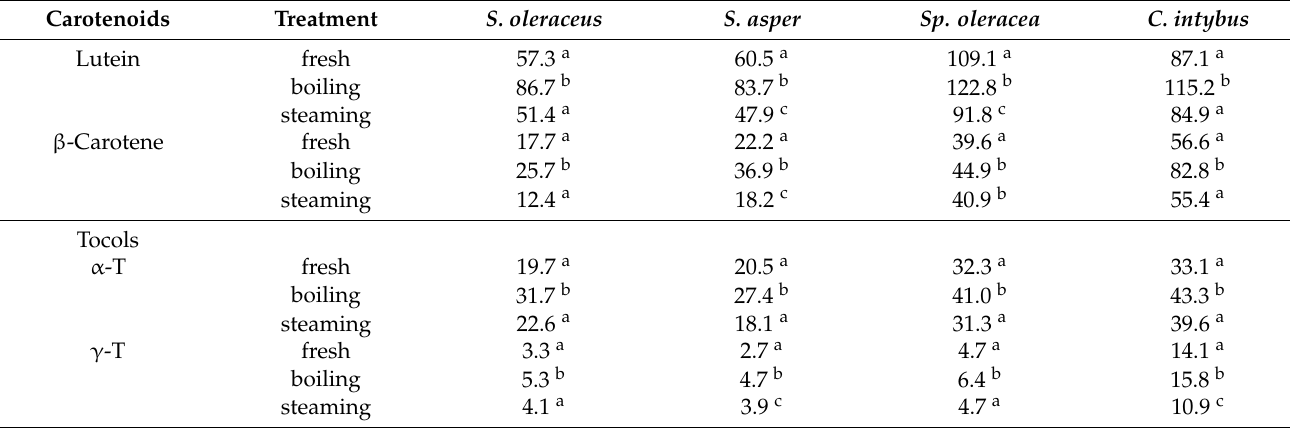
Table 1. Contents of the main carotenoids and tocols in the investigated leafy vegetables before and after cooking (mg/100 g